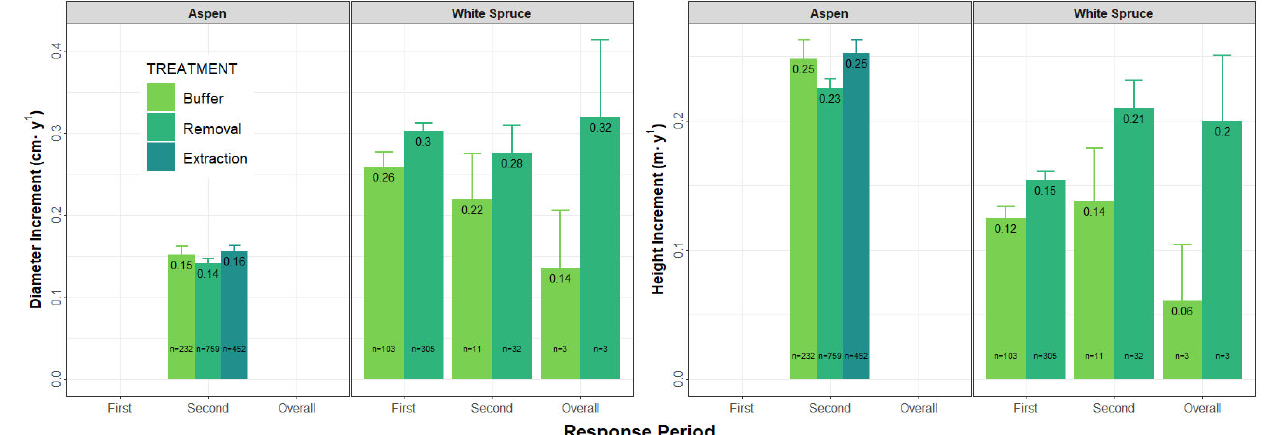
Figure 4. Summary of diameter and height growth responses at tree level by species and treatment. Lower tagging limit is 1.3 m height and upper tagging limit is 7.1 cm DBH for both species. Means and standard errors (error bars) are presented. Note: First response period (between Measurement 1 and 2) ranged from 5 to 7 years; for second response period (between Measurements 2 and 3), the time interval was 5 years. Between Measurements 1 and 3, the overall time interval was between 10 and 12 years.